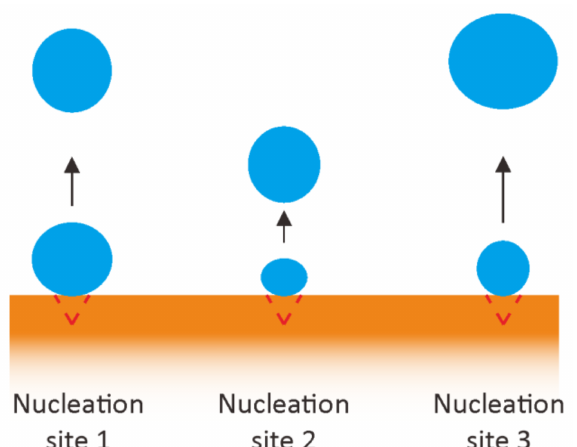
Figure 11. Illustration of bubble growth and departure from the isolated bubble